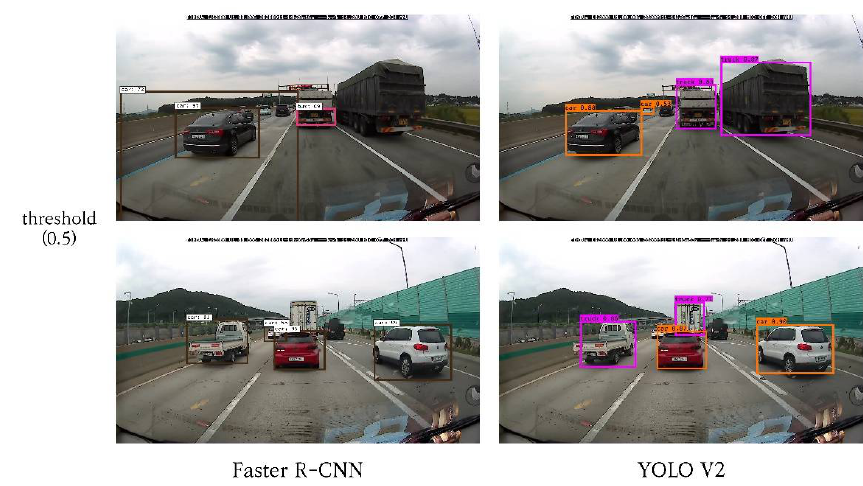
Figure 5. Learning results of object detection and classification—threshold 0.5.